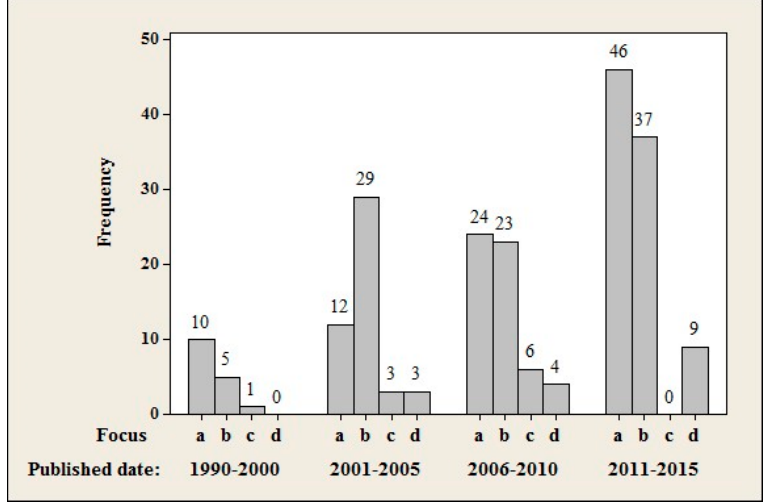
Figure 9. Summary of focus of ITCD and related literature by publication date (Focus code-a: Algorithm development; b: Application; c: Both algorithm development and application; d: Method comparison or review) ( N = 212).